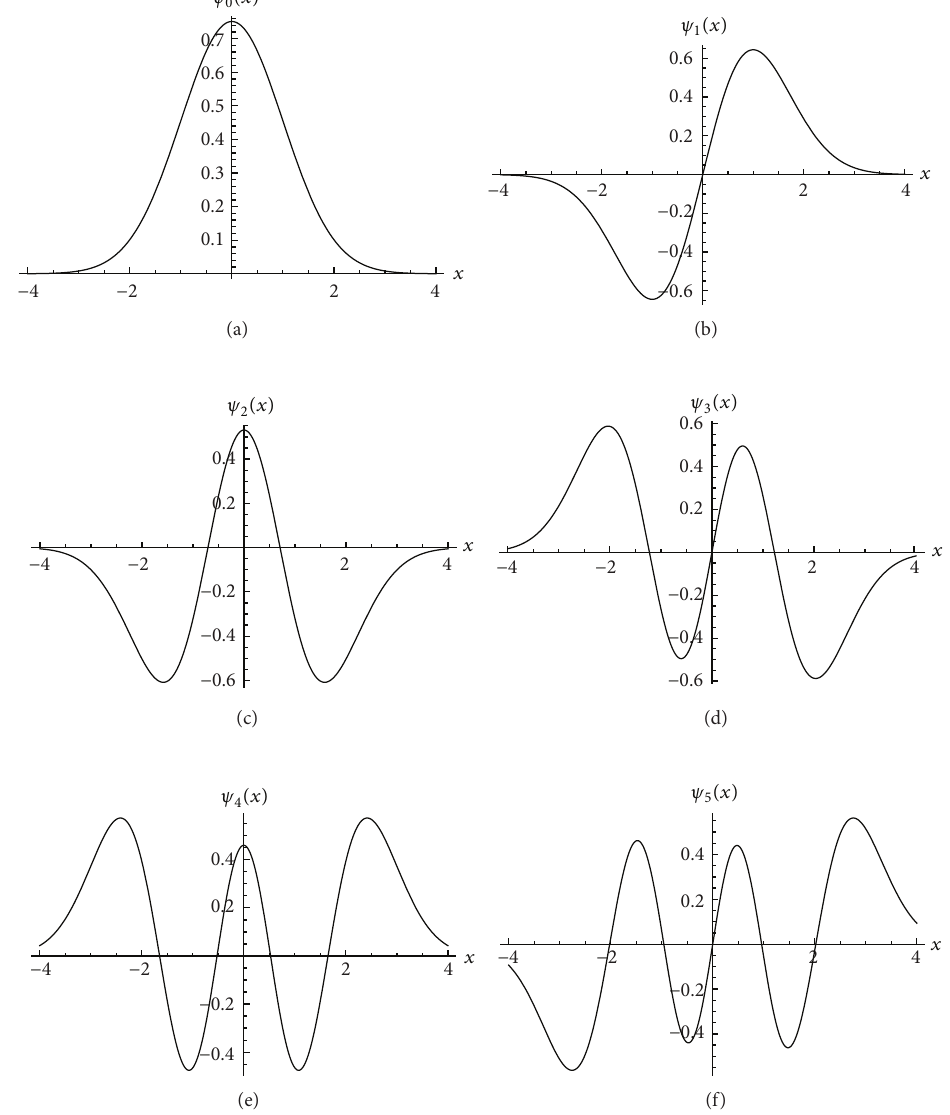
Figure 1: The first six states normalized eigenfunctions of the Harmonic potential given in